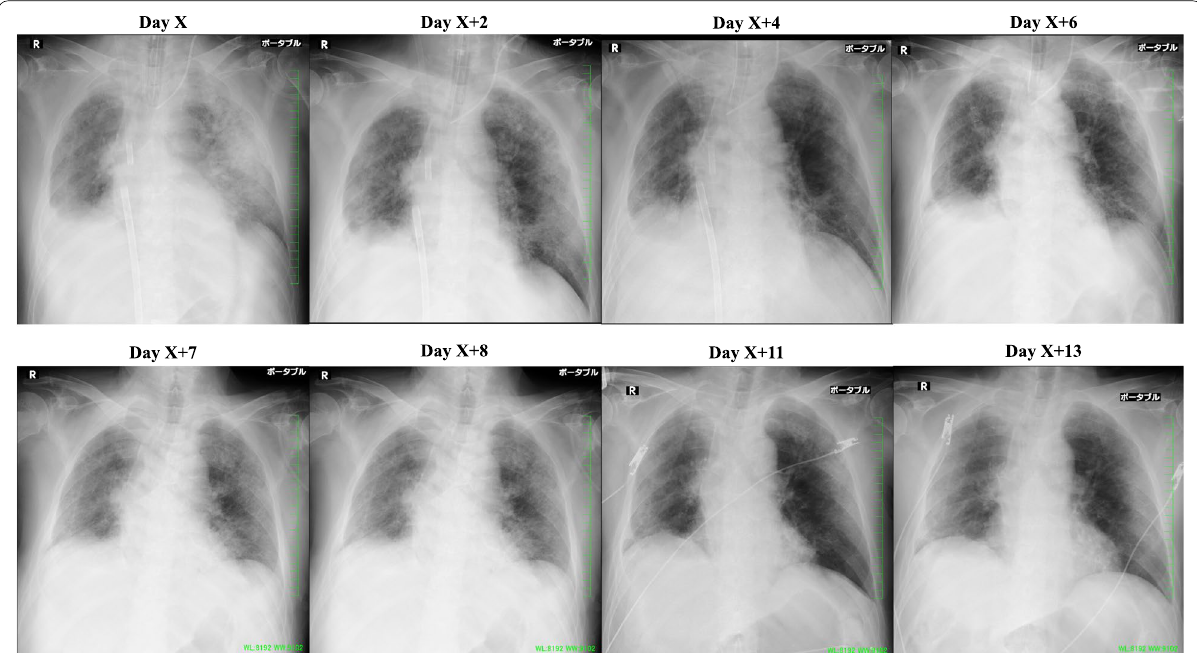
Fig. 2 X-ray images showing the disease course of interstitial pneumonia in the patient after postoperative readmission to hospital. At the time of introduction of ECMO, bilateral frosted shadows and mild congestive images were detected, partly due to the effect of infusion. With the course of treatment, the frosted shadows tended to disappear and the congestive images improved. After extubation, a slight deterioration was observed, but the patient showed a tendency toward improvement (day X +